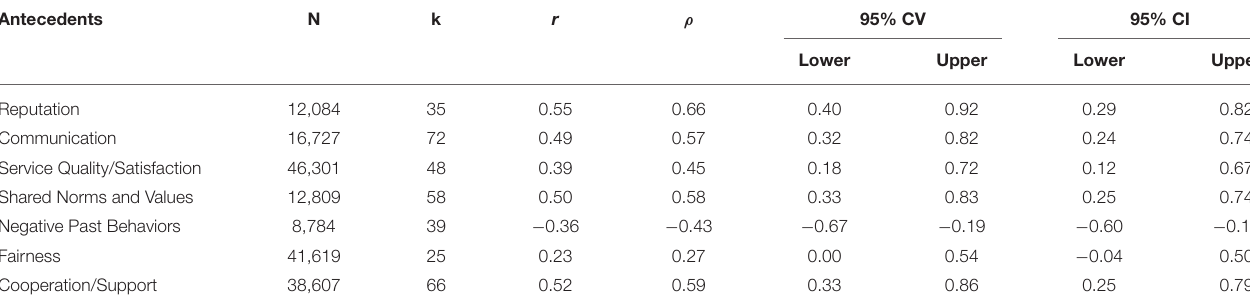
TABLE 2 | Meta-analytic antecedents of trust.